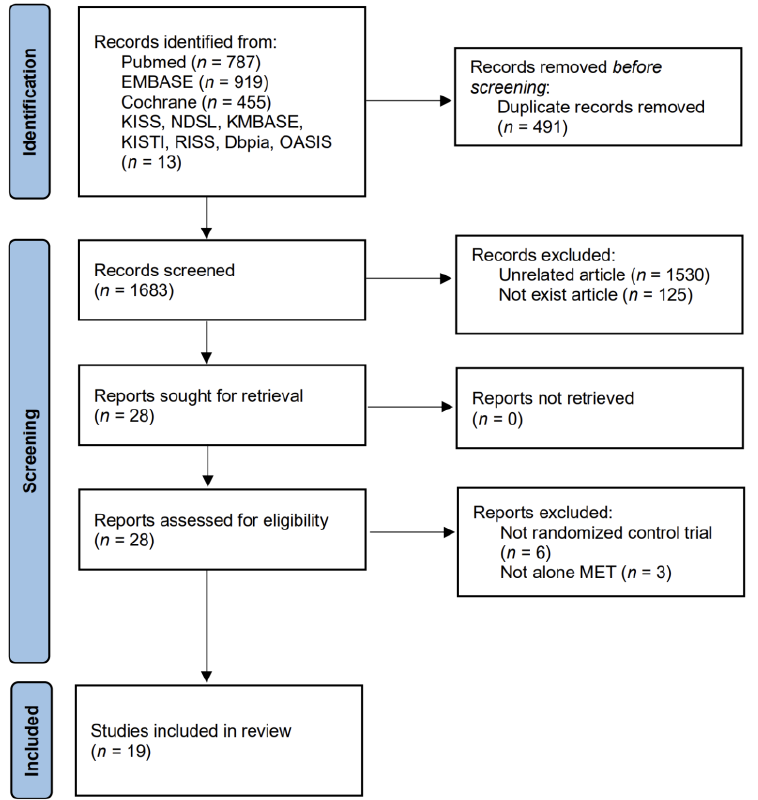
Figure 1. A flow chart diagram describing the trial selection process. n : number of articles; MET: muscle energy technique; RCT: randomized controlled trial. Table 1. Clinical studies on the use of MET on the